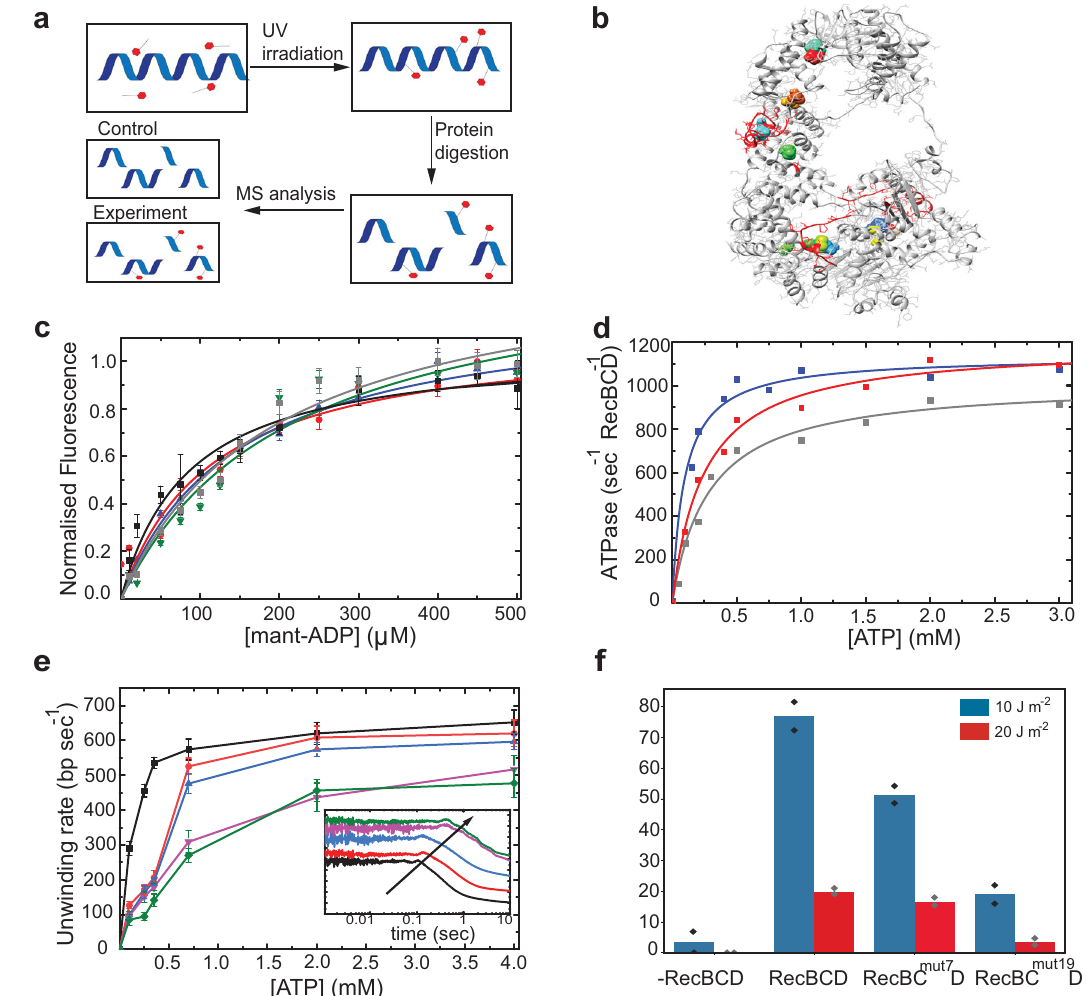
Fig. 5 Identi fi cation of the auxiliary sites and characterization of RecBC mut Ds. a Cross-linking of RecBCD with 8-azido-modi fi ed ADP and ATP, followed by MS analysis (CL-MS) to identify the auxiliary ATP binding sites in the RecC subunit. b Structure of the RecC subunit from RecBC mut19 D. The peptides from the CL-MS analysis and the mutations introduced were marked on the X-ray crystal structure of the RecC subunit (PDB-1W36) using Pymol. c Titration curves of mantADP to RecBC mut4 D (Black), RecBC mut7 D (Red), RecBC mut13 D (Blue), RecBC mut19 D (Green), and RecBC mut19 D in the presence of 2 mM adenosine (Gray) exhibit a monophasic pattern. The binding between fl uorescent nucleotide analog mantADP and RecBC mut D is measured as a Fo ̈ rster resonance energy transfer (FRET) signal between the intrinsic tryptophans (l ext = 280 nm) and the mant-nucleotides (l em = 436 nm). Data are shown as mean ± s.e.m., n = 3 independent experiments. d ATP concentration-dependence of RecBCD steady-state ATP turnover velocity (ATPase activity) of RecBCD (Blue), RecBCD mut7 D (Red), and RecBC mut19 D (Gray). The solid lines through the data points are the best fi ts to the quadratic form of the Briggs – Haldane equation (Eq. 2). e Unwinding rates of RecBCD (Black), RecBC mut4 D (Red), RecBC mut7 D (Blue), RecBC mut13 D (Purple), and RecBC mut19 D (Green) as a function of [ATP], calculated from the slope of lag-time vs. construct length curves, which were obtained by averaging n = 10 experimental traces. Error bars indicate the standard error, as calculated from the fi t. The graph in the inset shows representative unwinding time courses of RecBCD and RecBC mut Ds (color-coded as in c ). The arrow points to the increasing t lag of the mutants. f Survival percentage of E. coli expressing WT, mutated, or lacking RecBCD (-RecBCD) following UV irradiation dosages of 10 J/m 2 (Blue) and 20 J/m 2 (Red). n = 2 independent